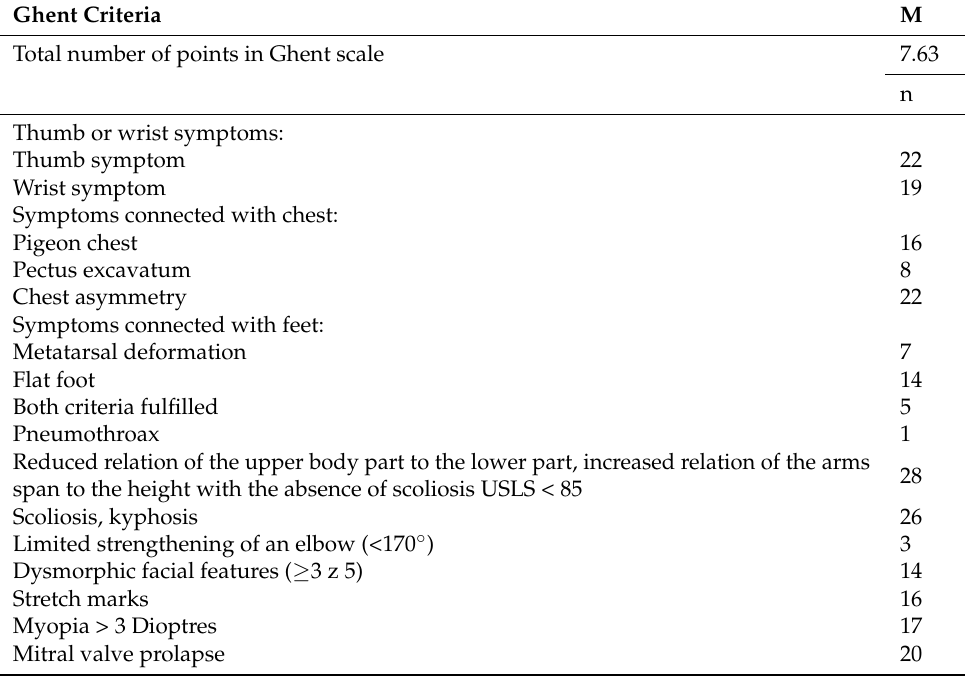
Table 3. Medical data concerning Ghent criteria in people with Marfan